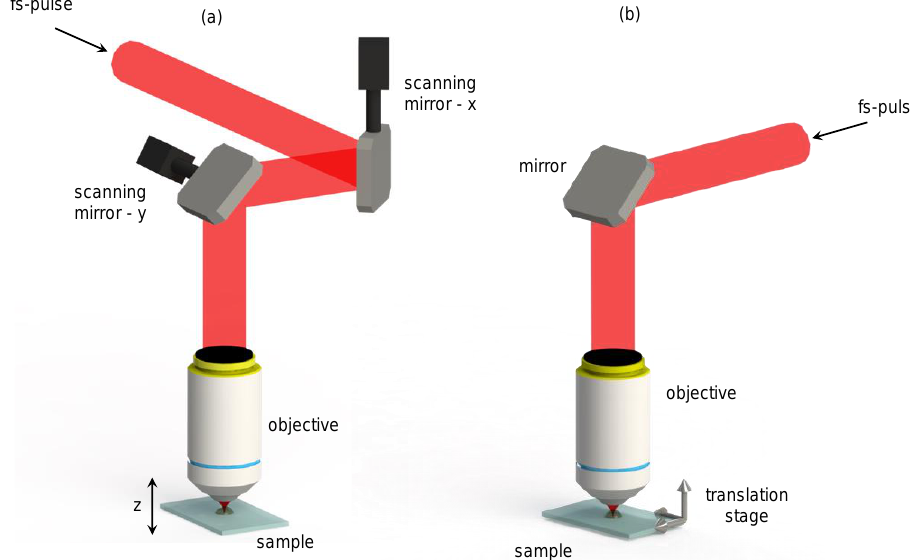
Figure 1. Schematic diagram of the experimental setup for femtosecond (fs)-laser processing of materials using ( a ) laser beam scanning mirror for beam deflection and ( b ) x - y - z translation stage for the sample.